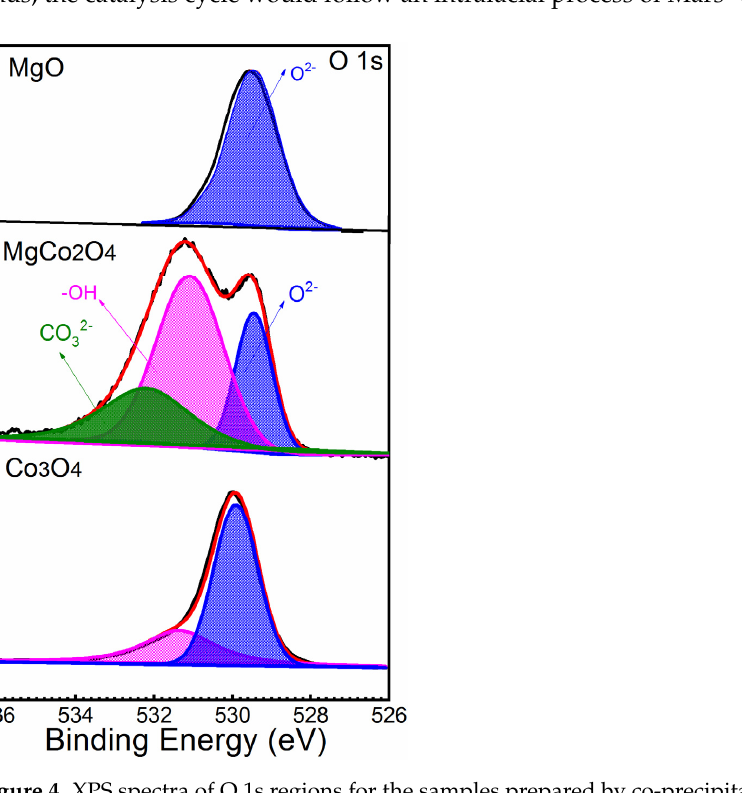
Figure 4. XPS spectra of O 1s regions for the samples prepared by co-precipitation method.